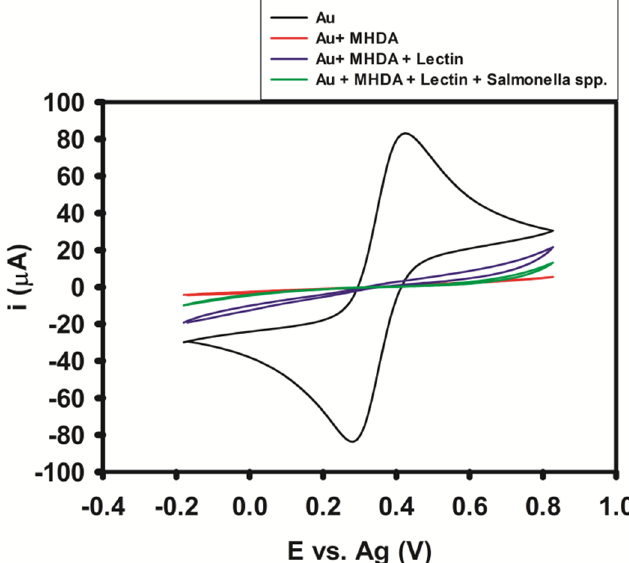
Figure 1. Cyclic voltammograms of the electrode surfaces at different stages of biosensor preparation, obtained in 40 µ L of 5.0 mM Fe(CN) 64 − / Fe(CN) 63 − solution, scan rate 20 mV s − 1 .